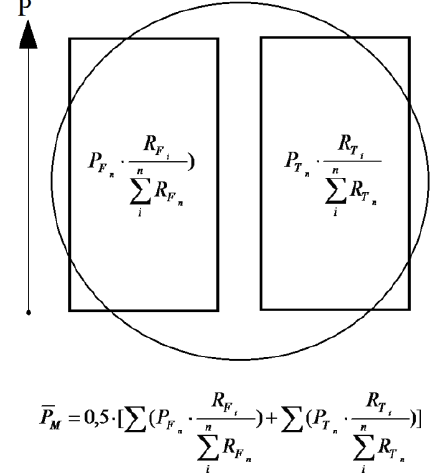
Fig. 1. General graphical interpretation of complex-weighted forecasting model (Source: compiled by